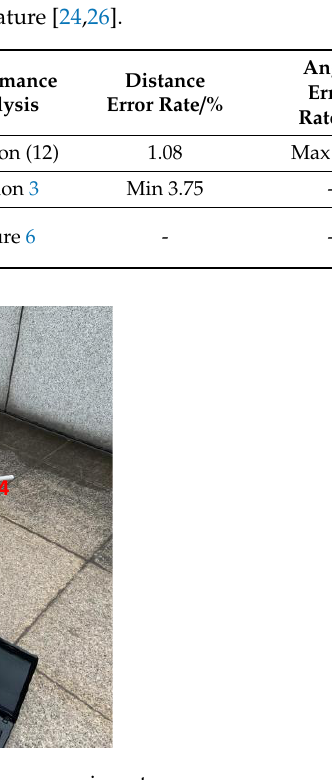
Figure 8. The scene photo of the outdoor experiment.